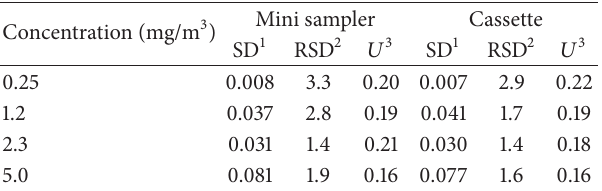
Table 2: Performance evaluation of HF measurements from test atmospheres.